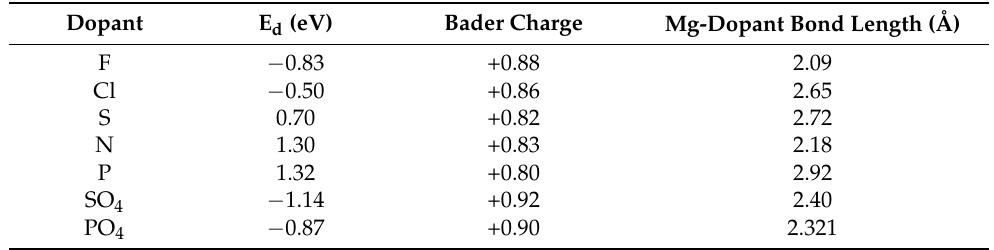
Table 3. Doping energy (E d ) of each dopant and its Bader charge and bond length with nearest Mg in doped 2D Mg(OH) 2